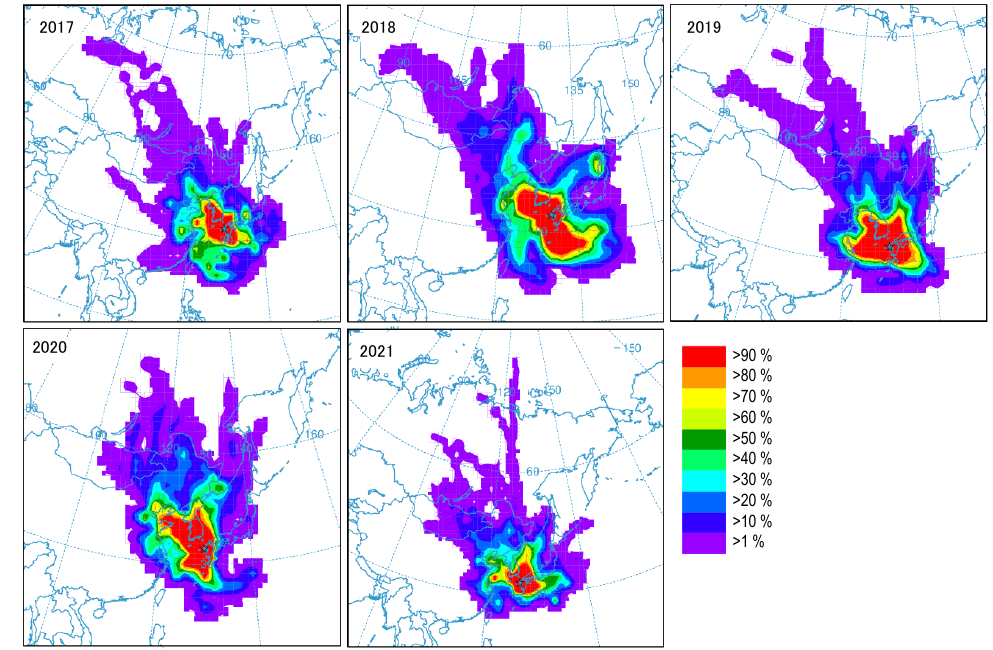
Figure 3. Frequency of residence of back trajectories in a grid cell in spring calculated by HYSPLIT Model of the National Oceanic and Atmospheric Administration, USA. The analysis period was set from 29 March to 3 May in each year.